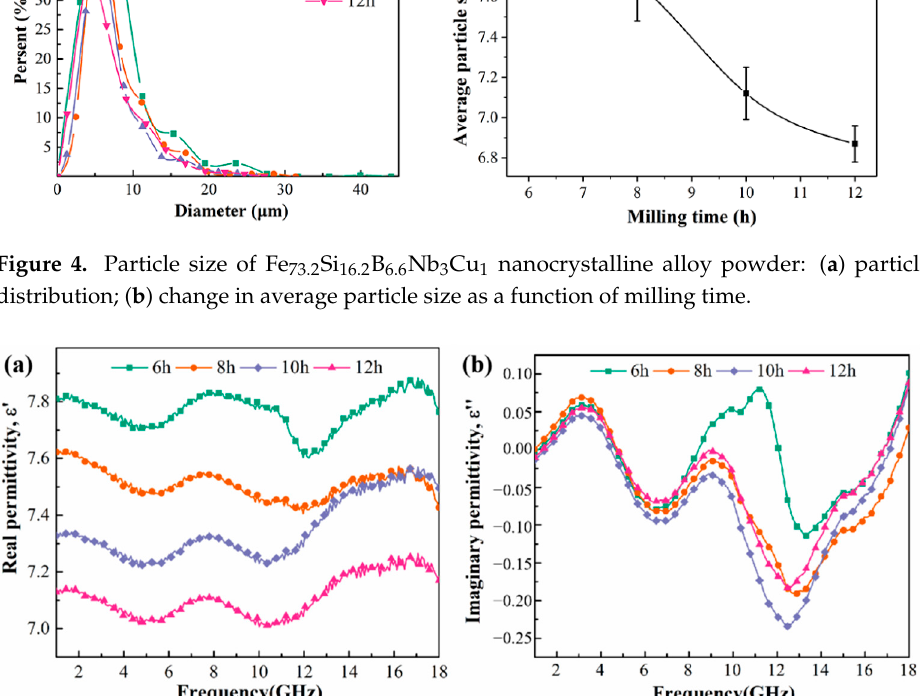
Figure 5. Frequency dependences of ε ′ ( a ) and ε ″ ( b ) of Fe 73.2 Si 16.2 B 6.6 Nb 3 Cu 1 nanocrystalline alloy powder. alloy